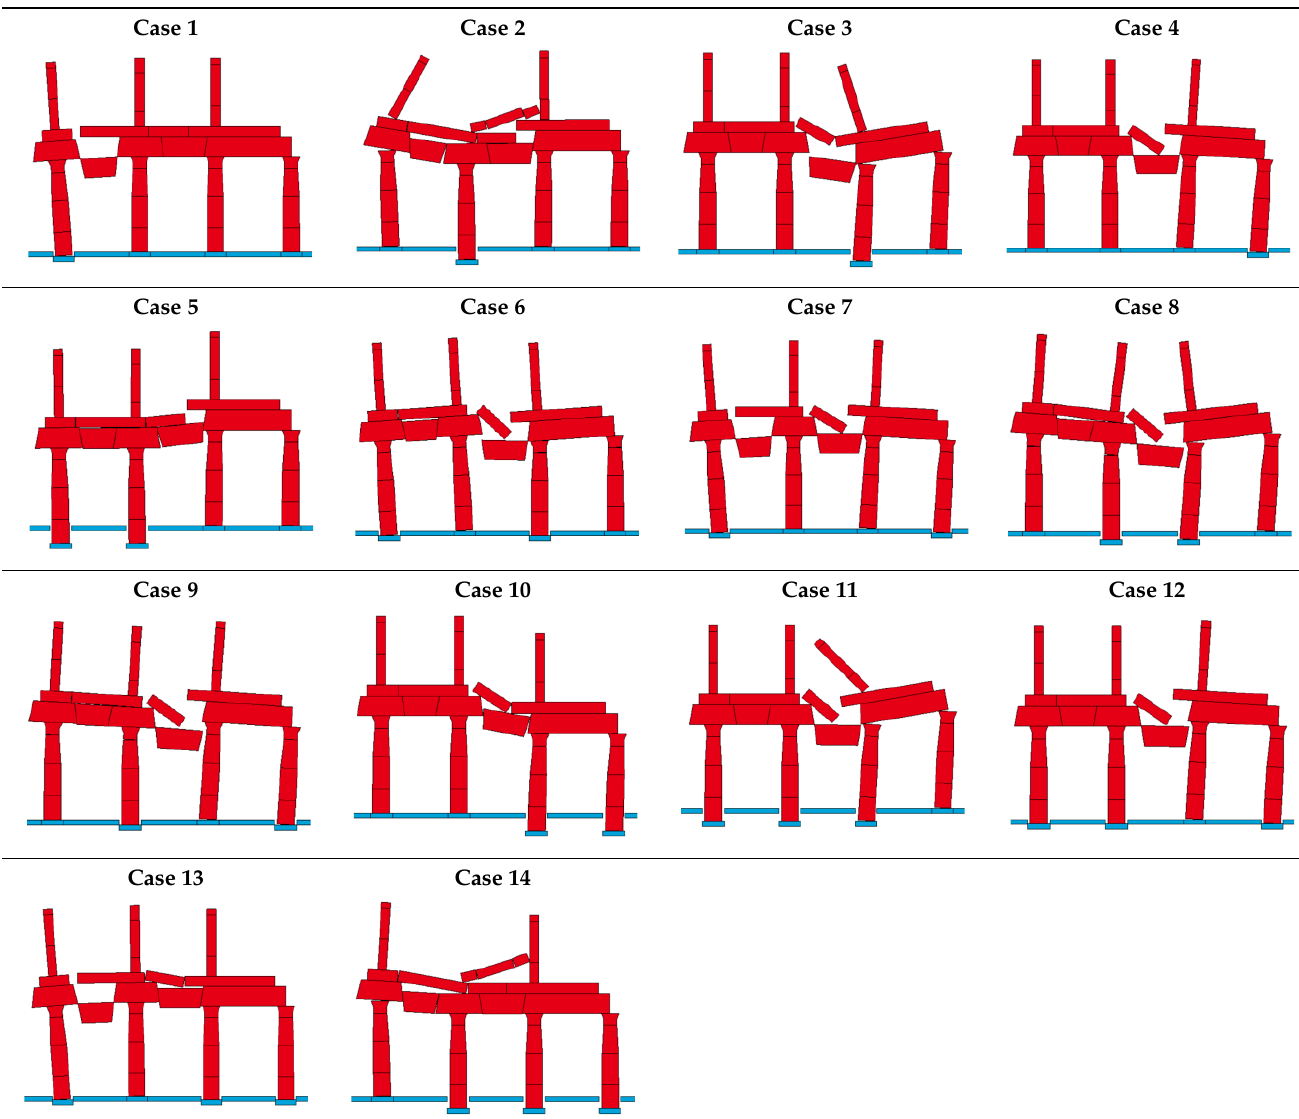
Table 4. Failure of the colonnade due to differential settlement without considering fracture.